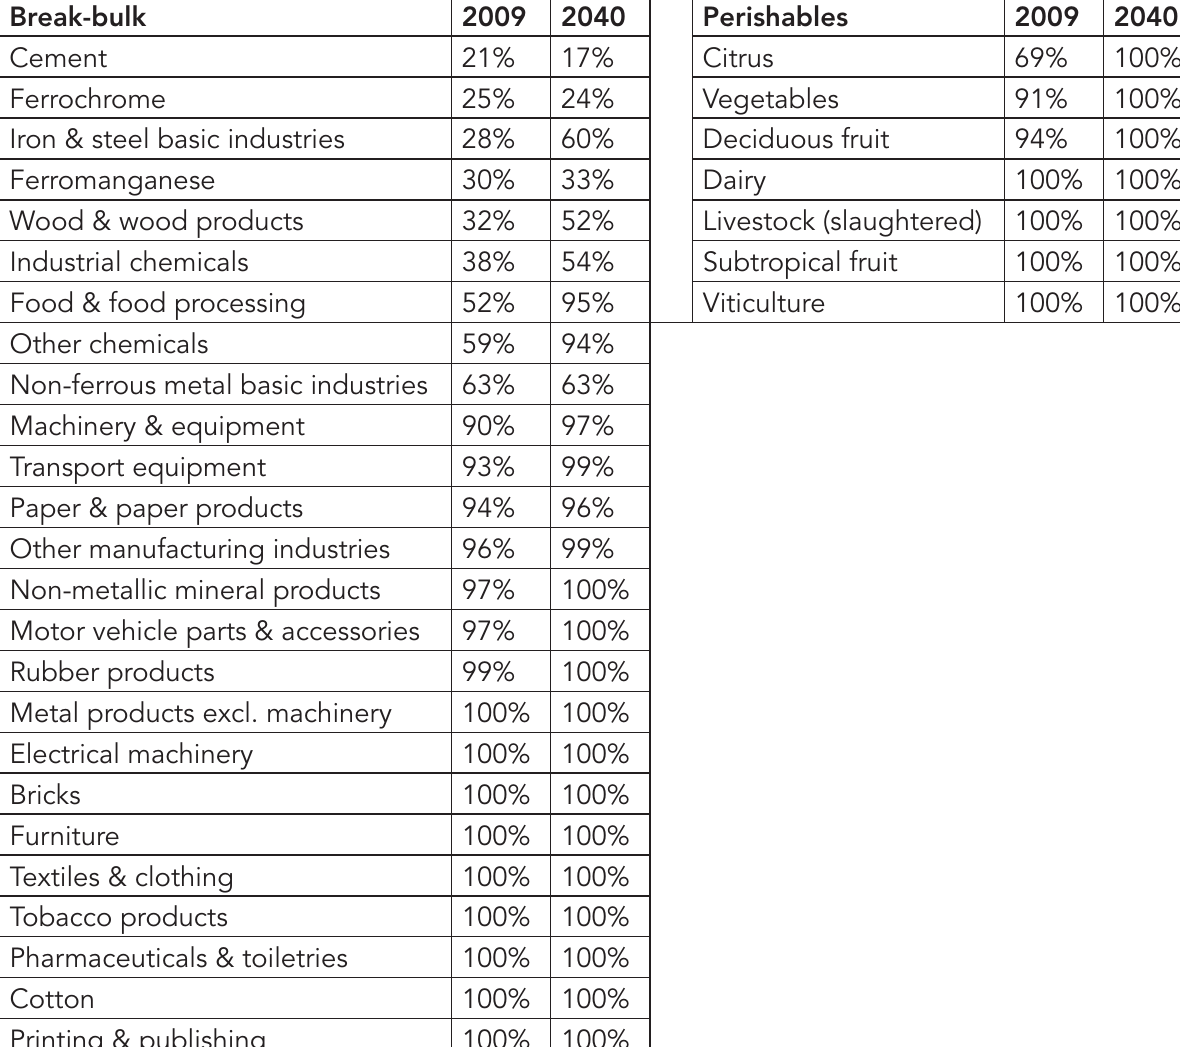
Table 1: Percentage containerisation per commodity for 2009 and 2040 (sorted according to